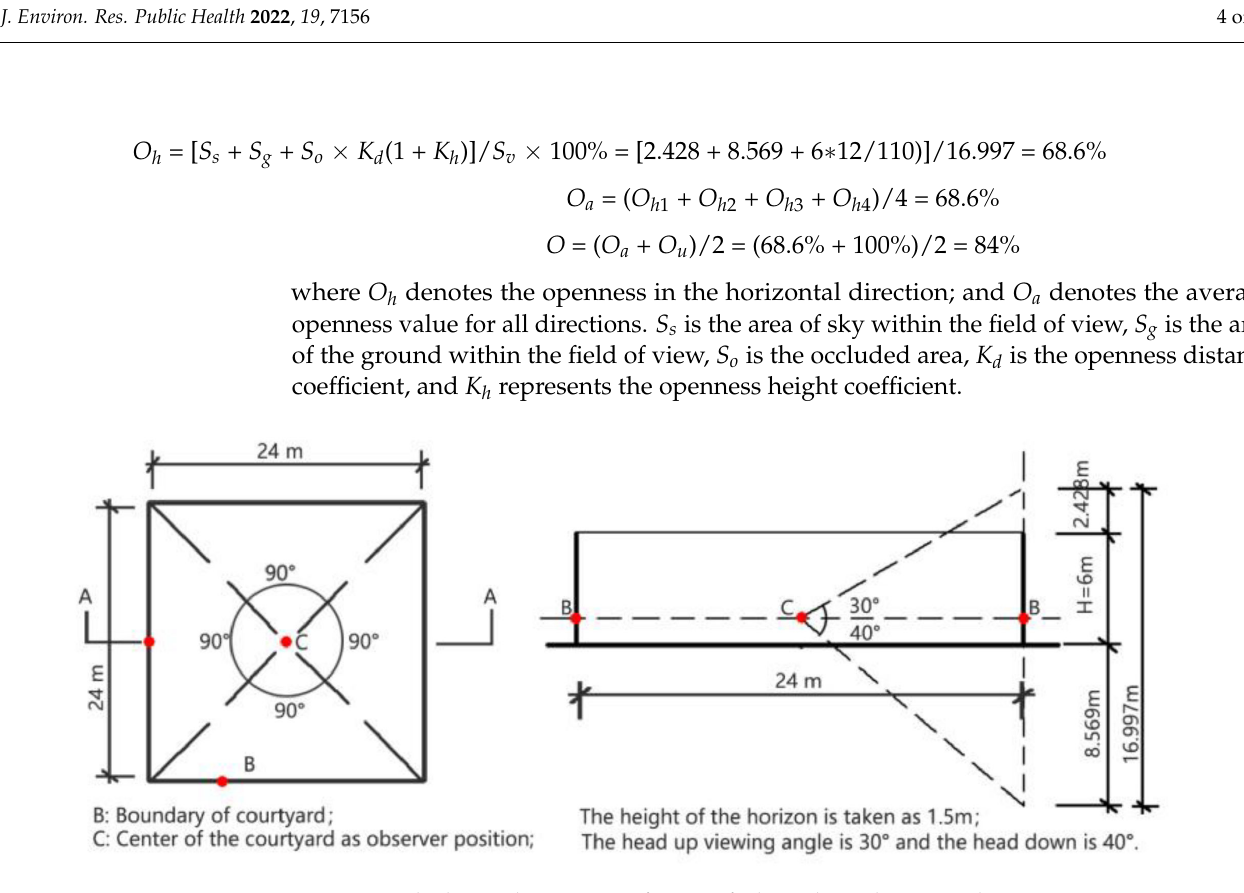
Figure 1. Calculating the openness factors of a hypothetical